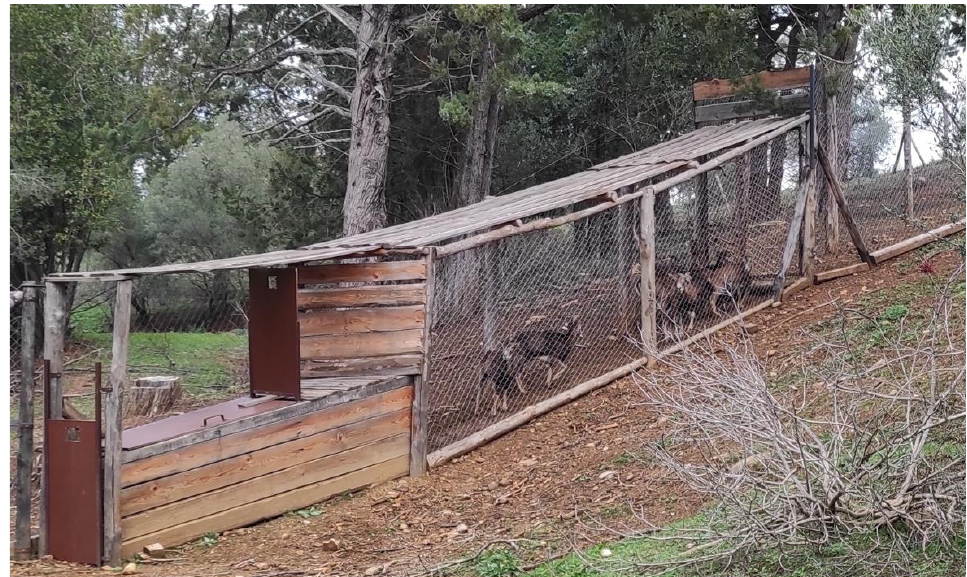
Figure 1. Funnel-shaped enclosure ending in a crate-shaped device with a guillotine opening to contain the animals.